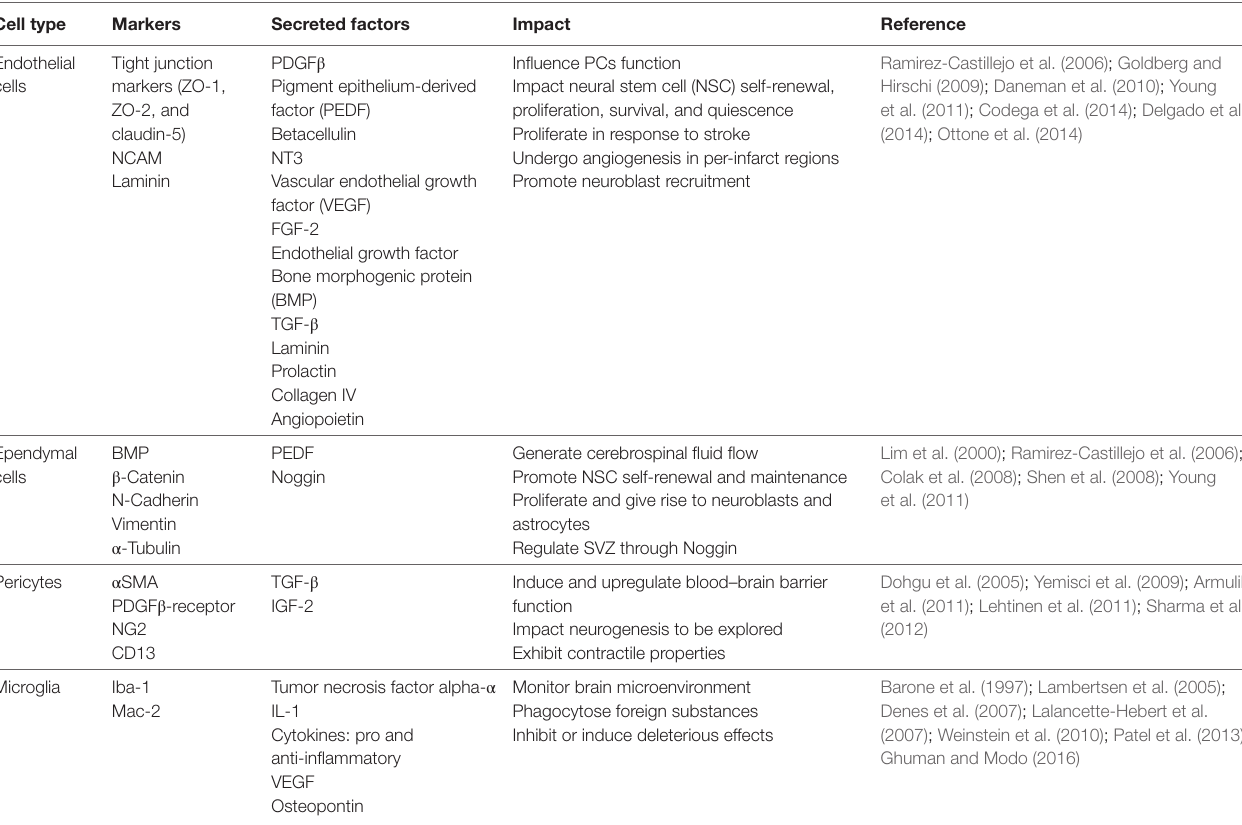
TABLe 2 | Resident cell types of the subventricular zone (SVZ) niche, including endothelial cells, ependymal cells, pericytes (PCs), and microglia, with their respective cellular markers, secreted factors, and impact to other cells present in the